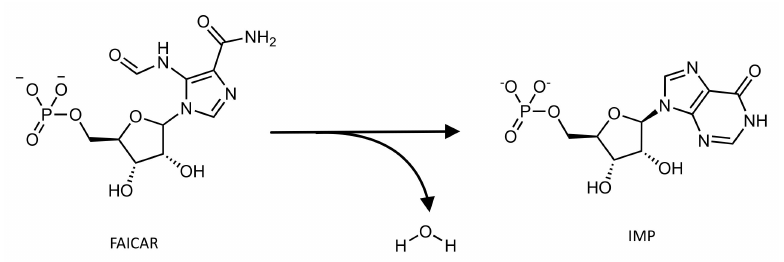
Figure 6. Schematic representation of the reaction catalyzed by the IMPCHase domain of the ATIC